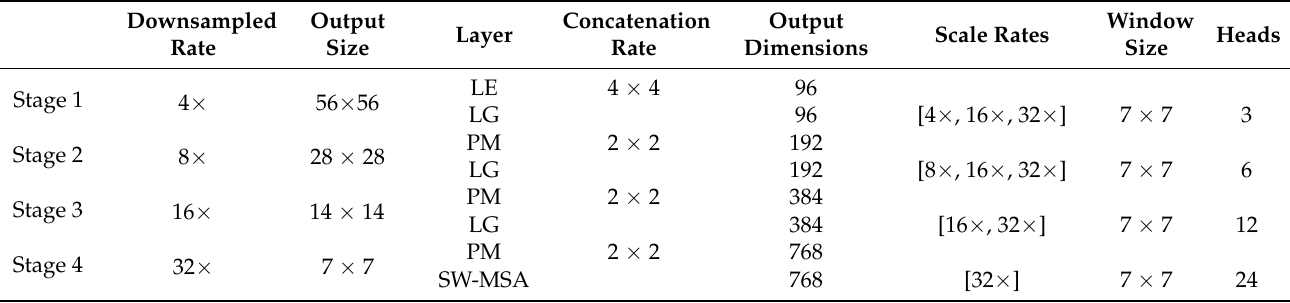
Figure 7. The architecture of the LEG Transformer. Table 1. Detailed configurations of the LEG Transformer.